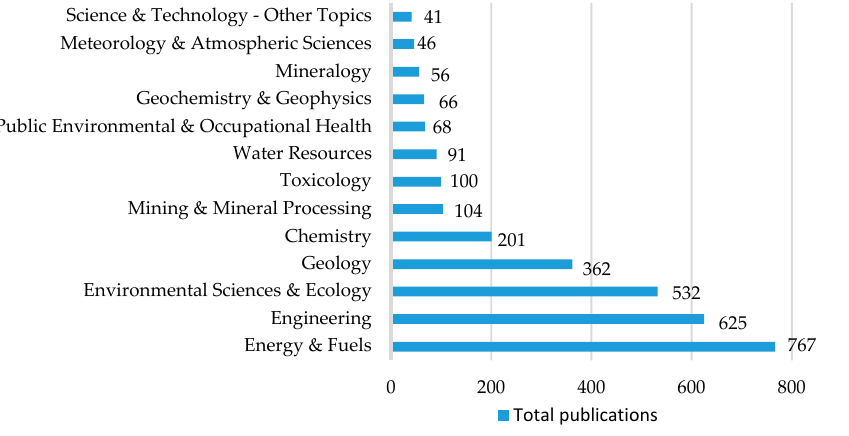
Figure 6. Publications of the most productive categories of trace elements in coal and ash.